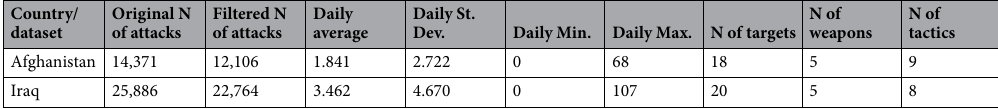
Table 1. Descriptive statistics of the Afghanistan and Iraq datasets reporting the total number of attacks that occurred between 2001 and 2018 and the total number of targets, weapons and tactics represented in the considered time